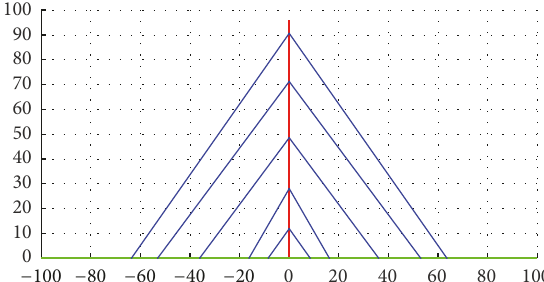
Figure 4: The best scheme obtained for the mast.